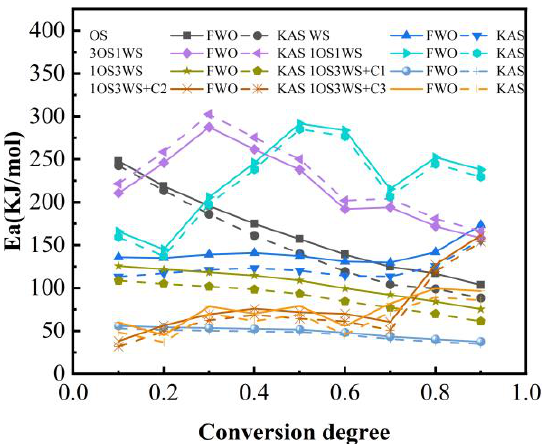
Figure 7. Variation of activation energy distribution of mixtures with degree of conver-